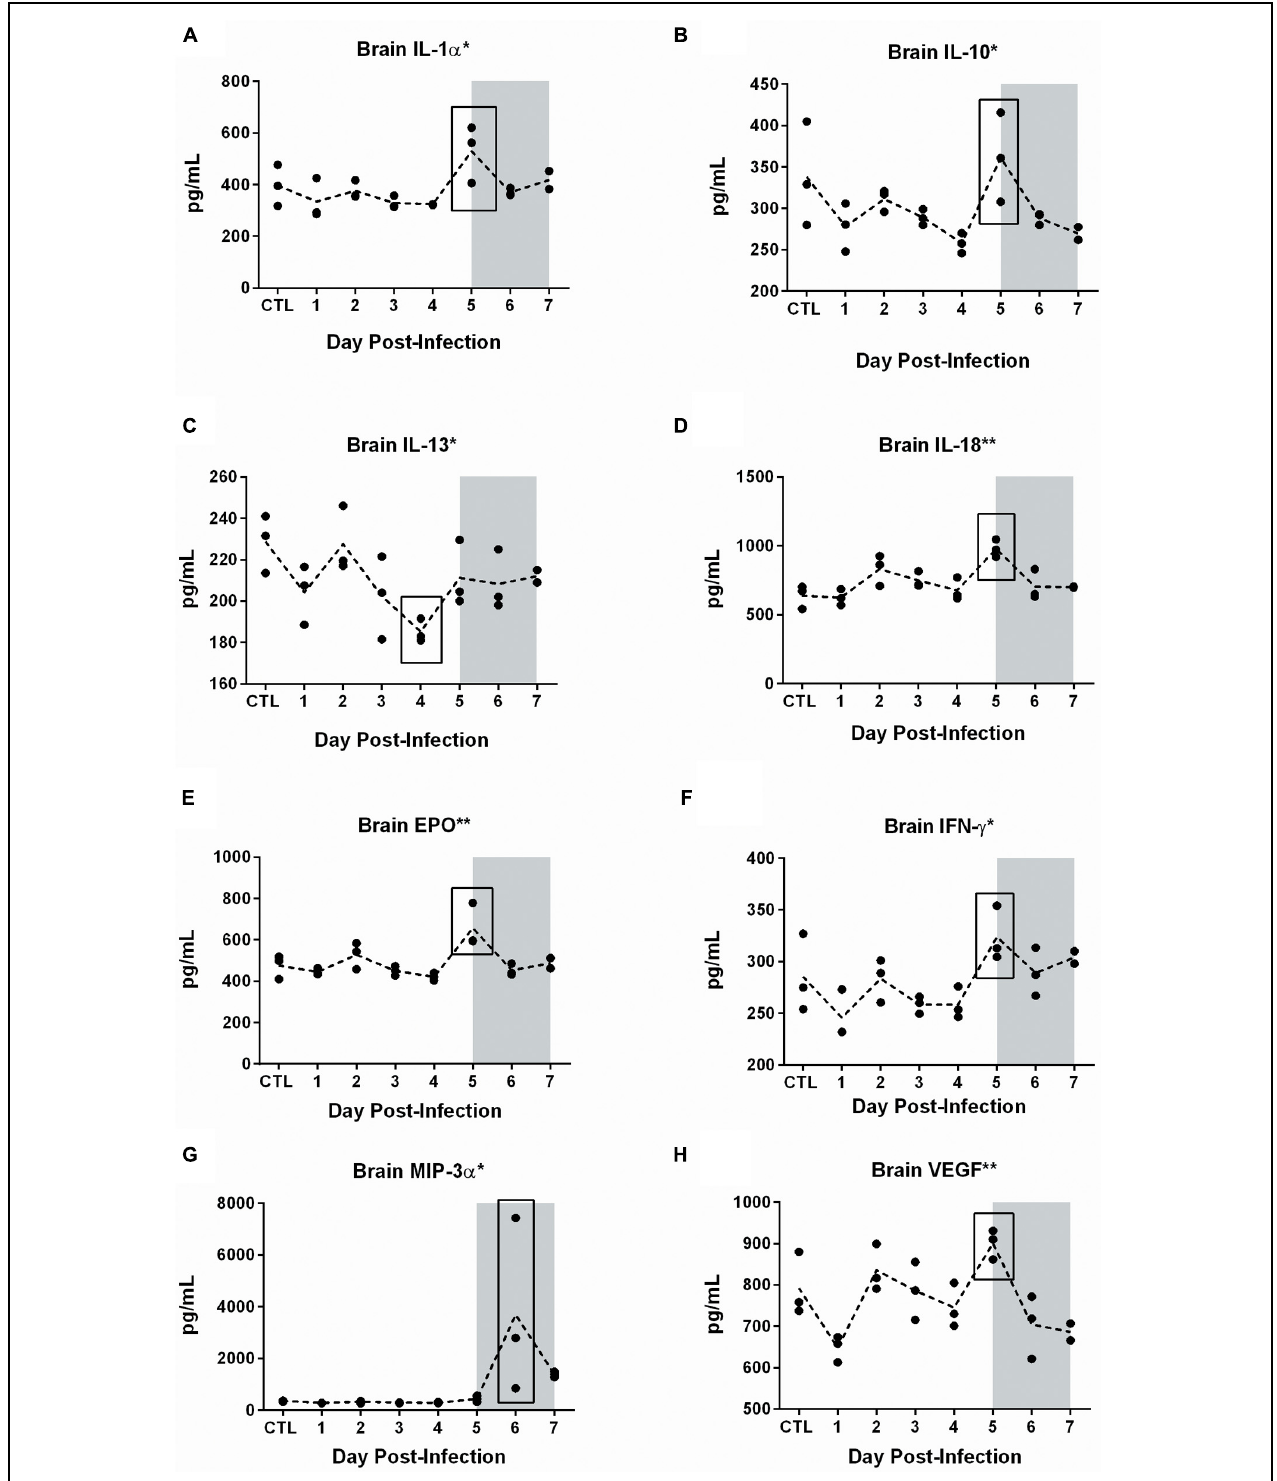
FIGURE 9 | Cytokine and chemokine dysregulation in the brain of RVFV-infected Lewis rats. The eight cytokines shown in this figure were statistically significant in brain but not serum. The level of significance by ANOVA is reflected by the number of asterisks on each graph title, where ∗ p ≤ 0.05, ∗∗ p ≤ 0.01, ∗∗∗ p ≤ 0.001, ∗∗∗∗ p ≤ 0.0001. Individual time points were compared to uninfected controls by t -test. Significant time points are indicated by the black box. The gray shaded box on all graphs represents the window of clinical disease (5–7 dpi).